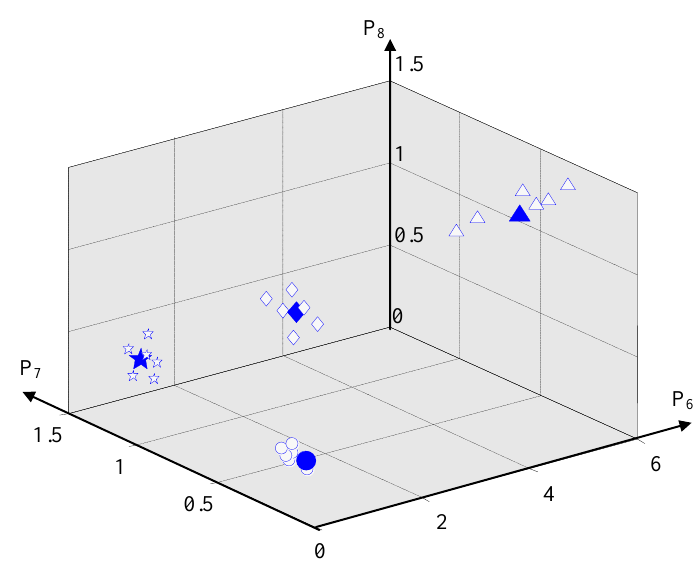
Figure 8. C lassification of the test signals.